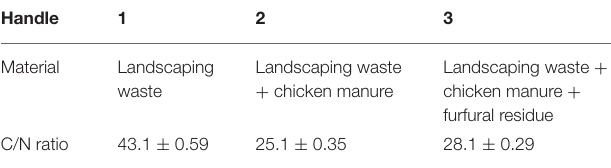
TABLE 2 | Experiment design of garden waste